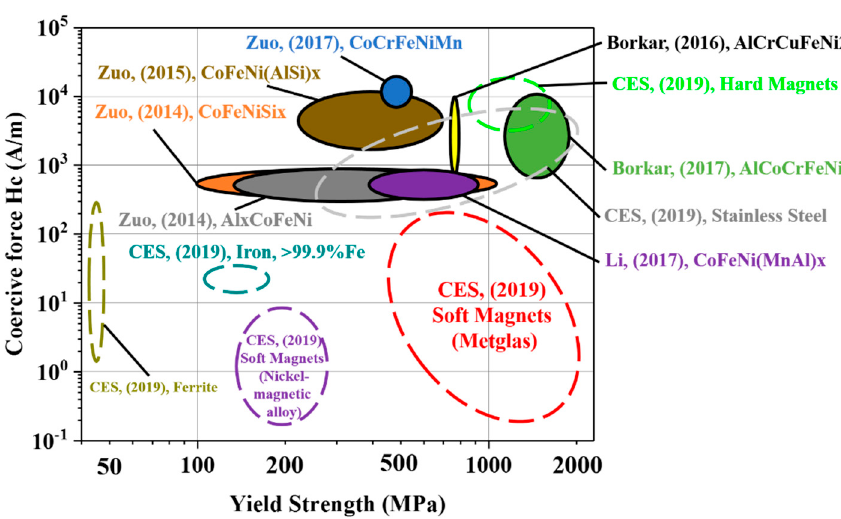
Figure 2. Coercive force vs. yield strength for conventional alloys (encircled by dashed lines) and HEAs (colored regions encircled by solid lines). (Data taken from [5,27,29,33,43,44,72,76,77,79,80]). The data is from the CES EduPack 2009, Granta Design, Limited, Cambridge, UK, 2009.